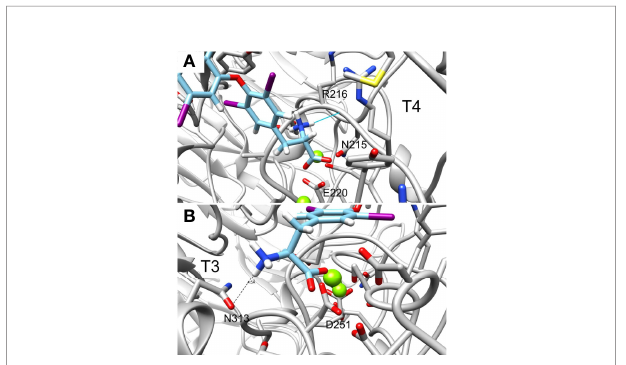
FIGURE 6 | Close up of the amine and carboxylic groups of T3 and T4 docked structures. Integrin ’ s binding site backbone (ribbons) and side chains (sticks) are colored gray with oxygen atoms in red and nitrogen in blue. (A) T4 amine group forms hydrogen bond with N215 backbone carbonyl while the carboxyl group form electrostatic interaction with Mg 2+ atom. (B) Similarly, T3 amine group form electrostatic interaction with N313 and the carboxyl group with Mg 2+ . Docked structures are colored as follows: carbon (cyan), nitrogen (blue) oxygen (red), hydrogen (white), and iodine